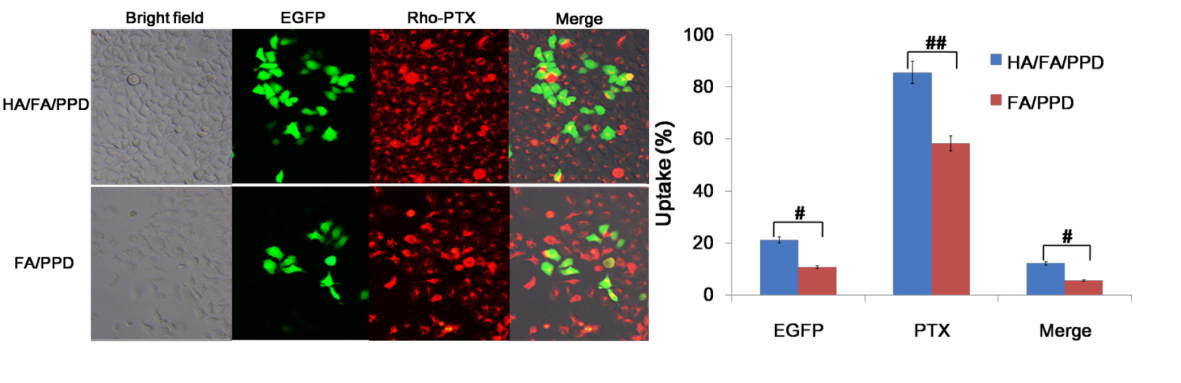
Figure 9. In vitro co-delivery efficacy of dual targeting HA/FA/PPD on HepG2 cells ( n = 3). HA/FA/PPD incubated with HepG2 cells for 4 h, while FA/PPD and PPD served as controls. ## p < 0.01, # p <